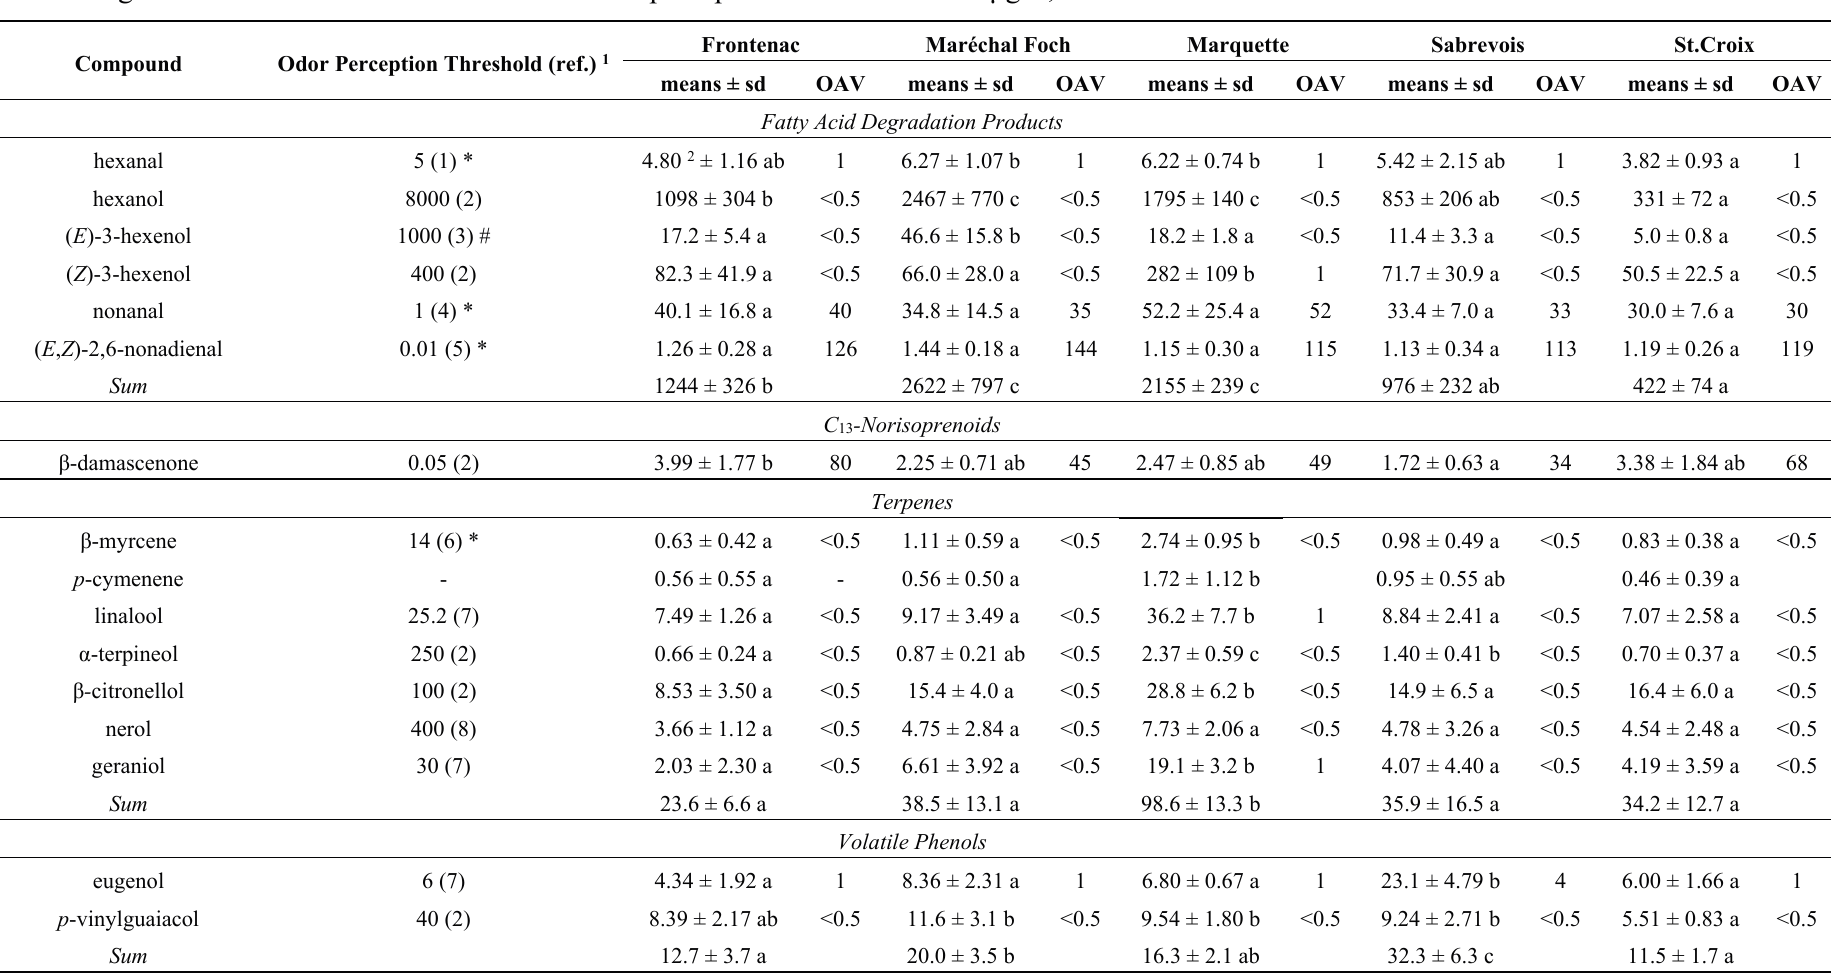
Table 4. Concentration, odor perception threshold and odor activity value (OAV) of free volatile compounds from wine made from the interspecific hybrid varieties Frontenac, Maréchal Foch, Marquette, Sabrevois and St. Croix harvested in the province of Québec (Canada), during the season 2012. Concentrations and odor perception thresholds are in μ g/L, unless otherwise